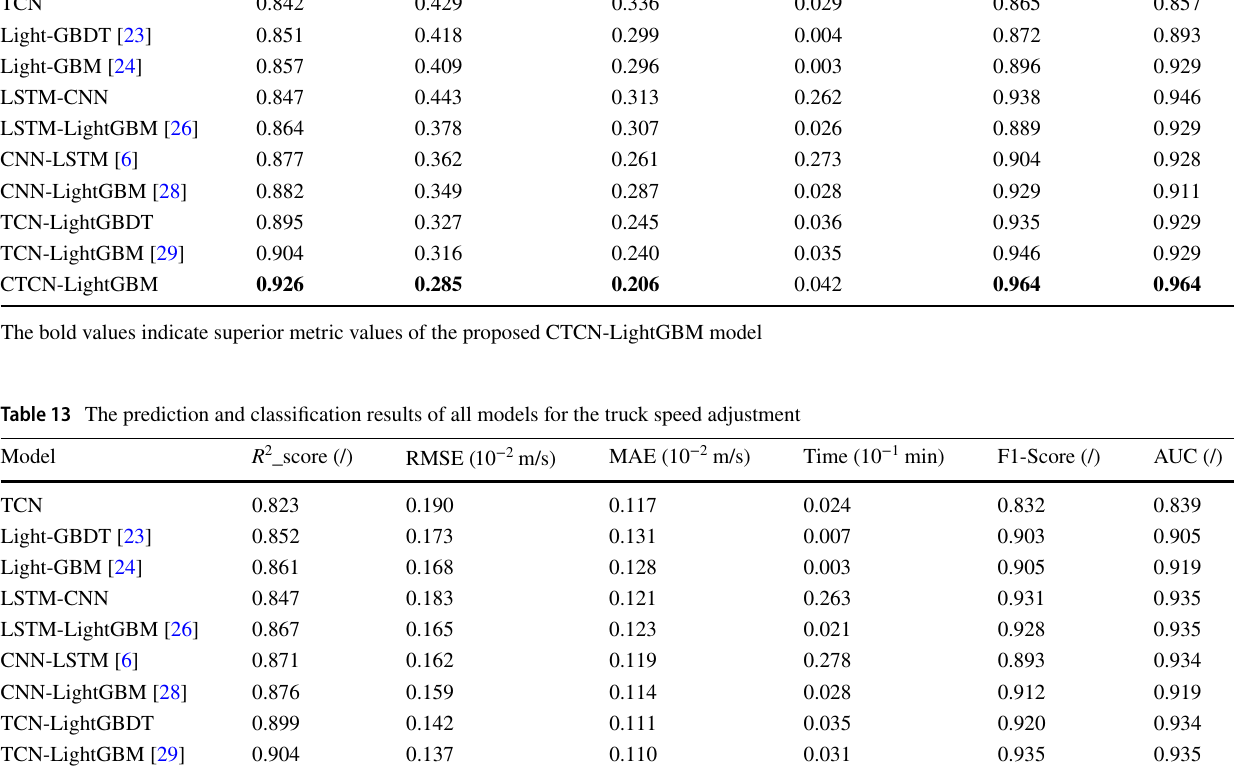
The bold values indicate superior metric values of the proposed CTCN-LightGBM